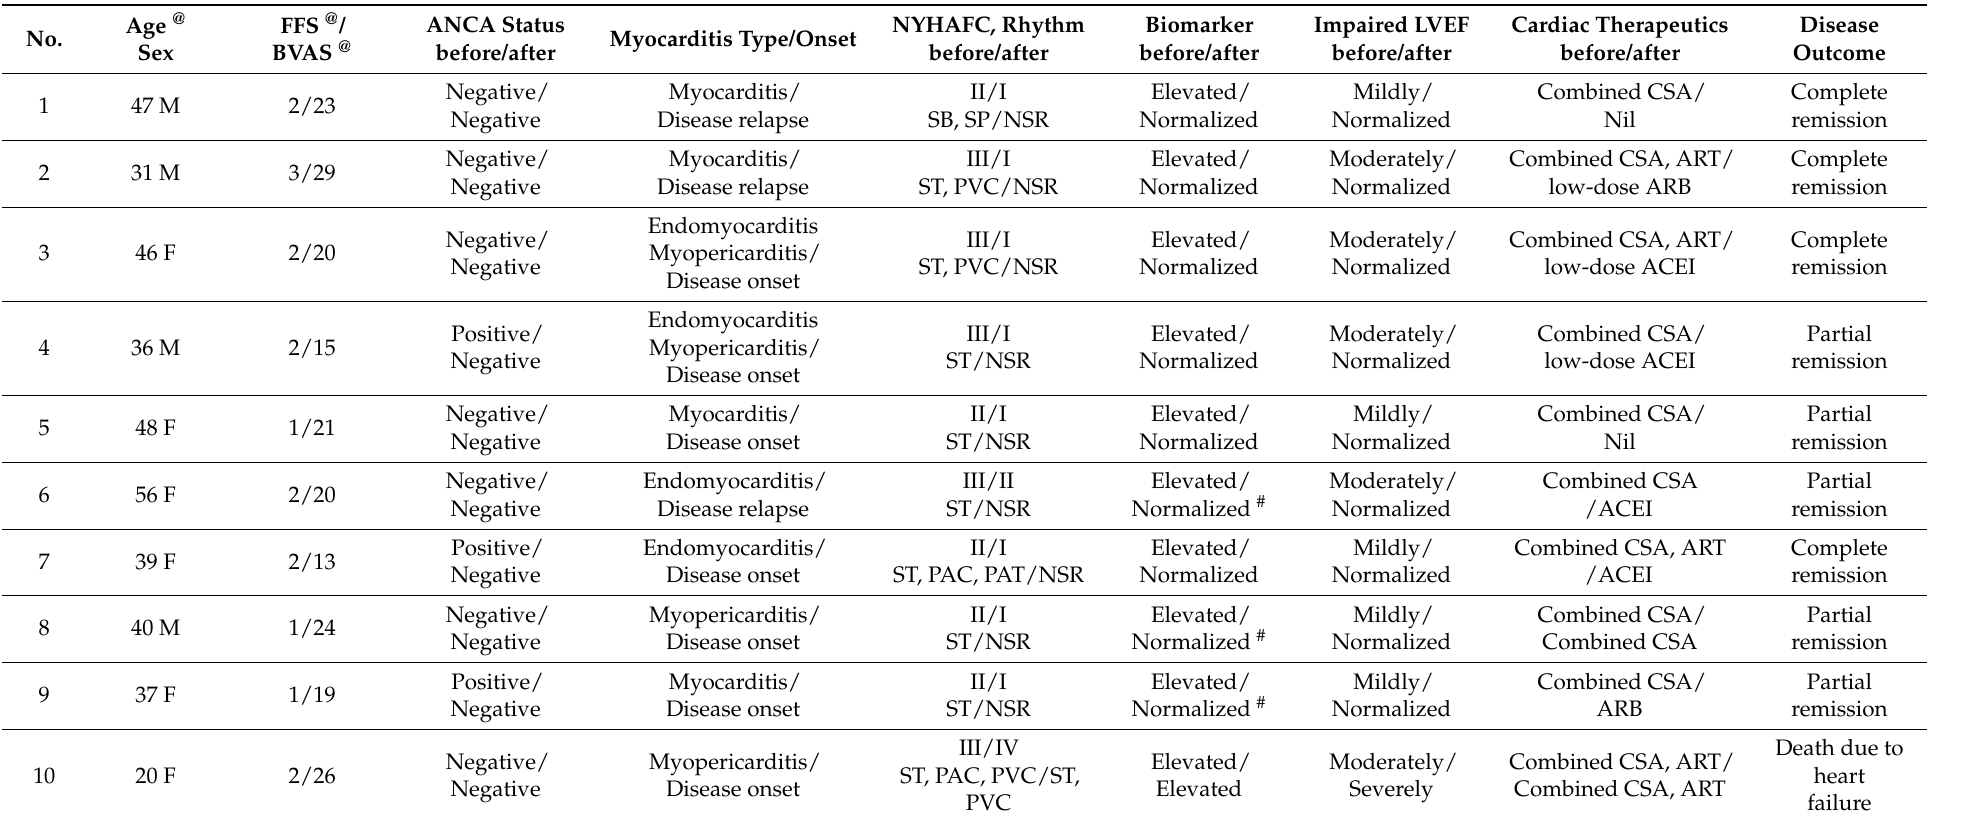
Table 2. Clinical, medication and outcome profiles before and after therapy in 10 EGPA patients with